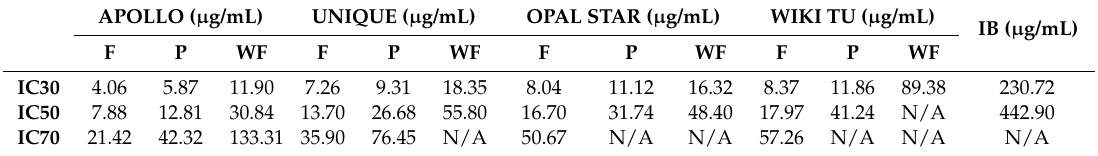
Table 3. Inhibition of SEAP expression by feijoa extracts and ibuprofen on the HEK-Blue™ hTLR2 cell line.